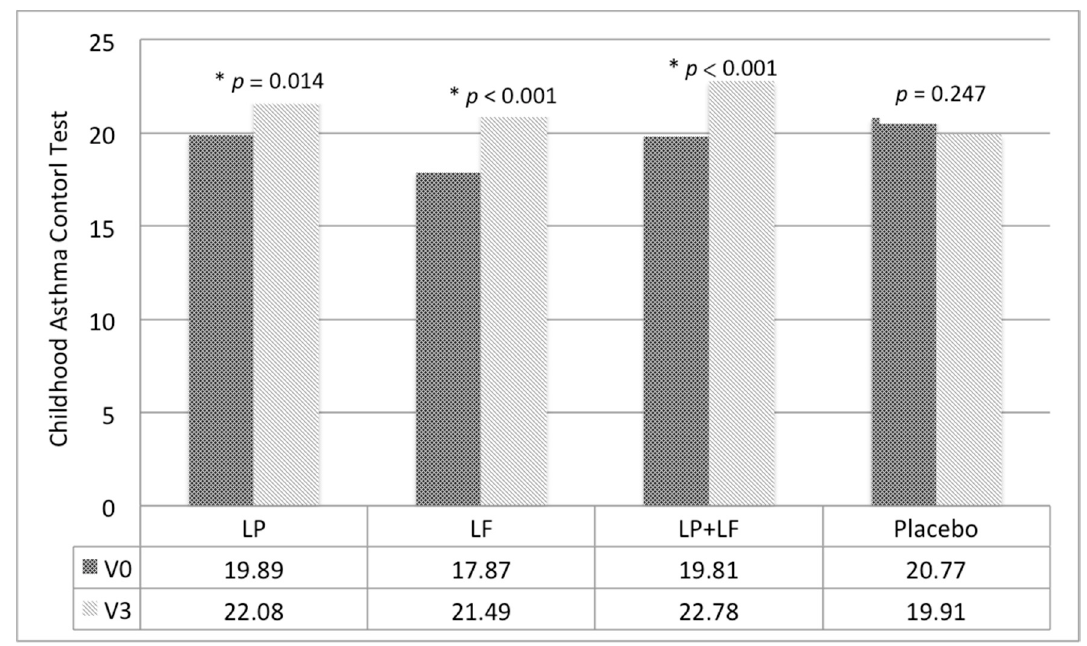
Figure 3. Intragroup differences in Childhood Asthma Control Test scores. * p < 0.05.